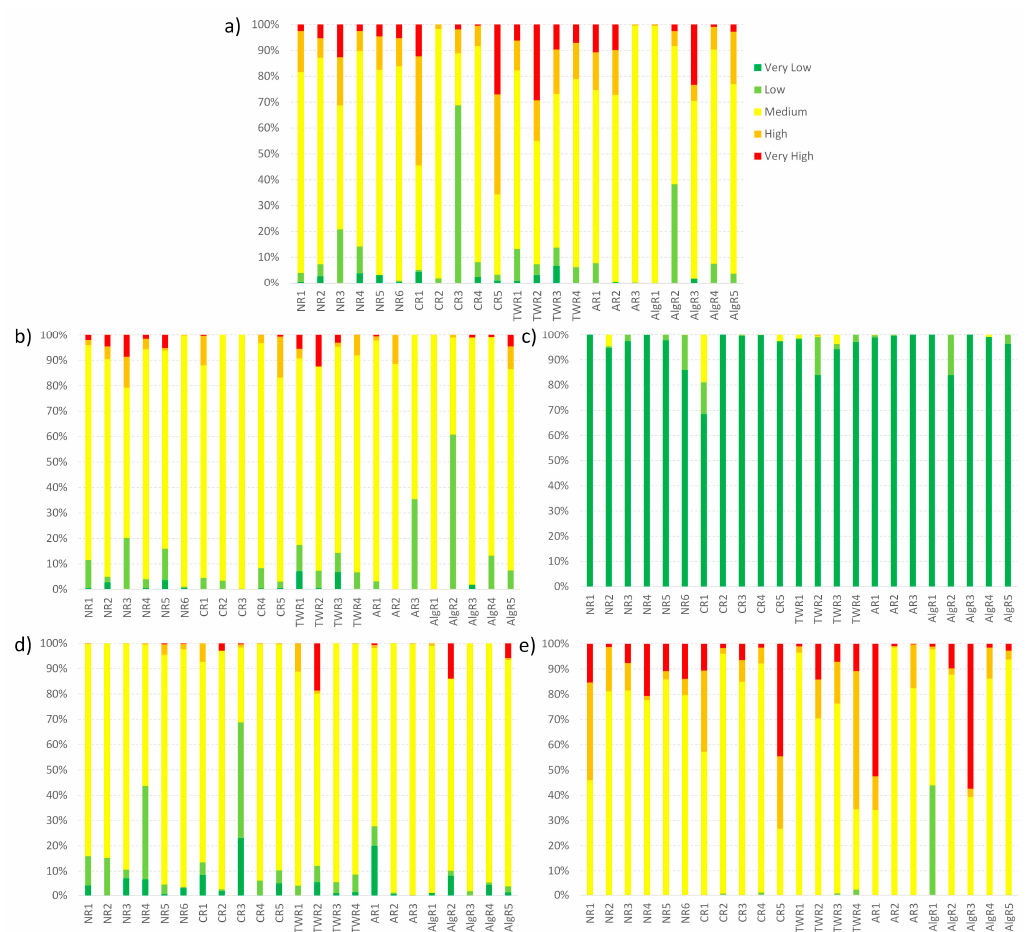
Figure 7. Vulnerability classes distribution in the flood-prone sites: ( a ) Flood vulnerability; ( b ) Population criterion; ( c ) Socioeconomics criterion; ( d ) Buildings criterion; ( e ) Exposed Elements criterion.